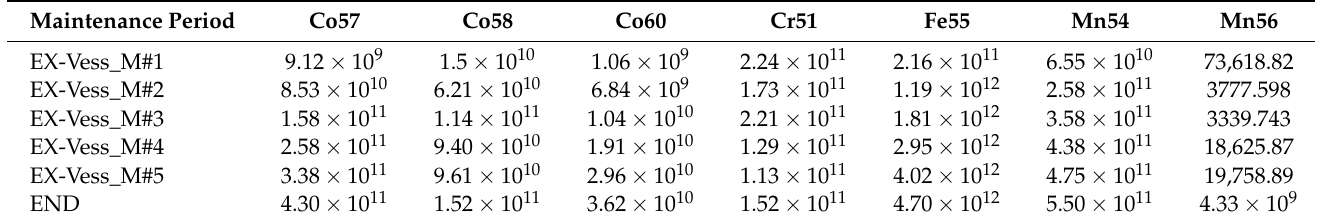
Table 1. Deposit activities in the different ex-vessel regions at the maintenance scheduled times in